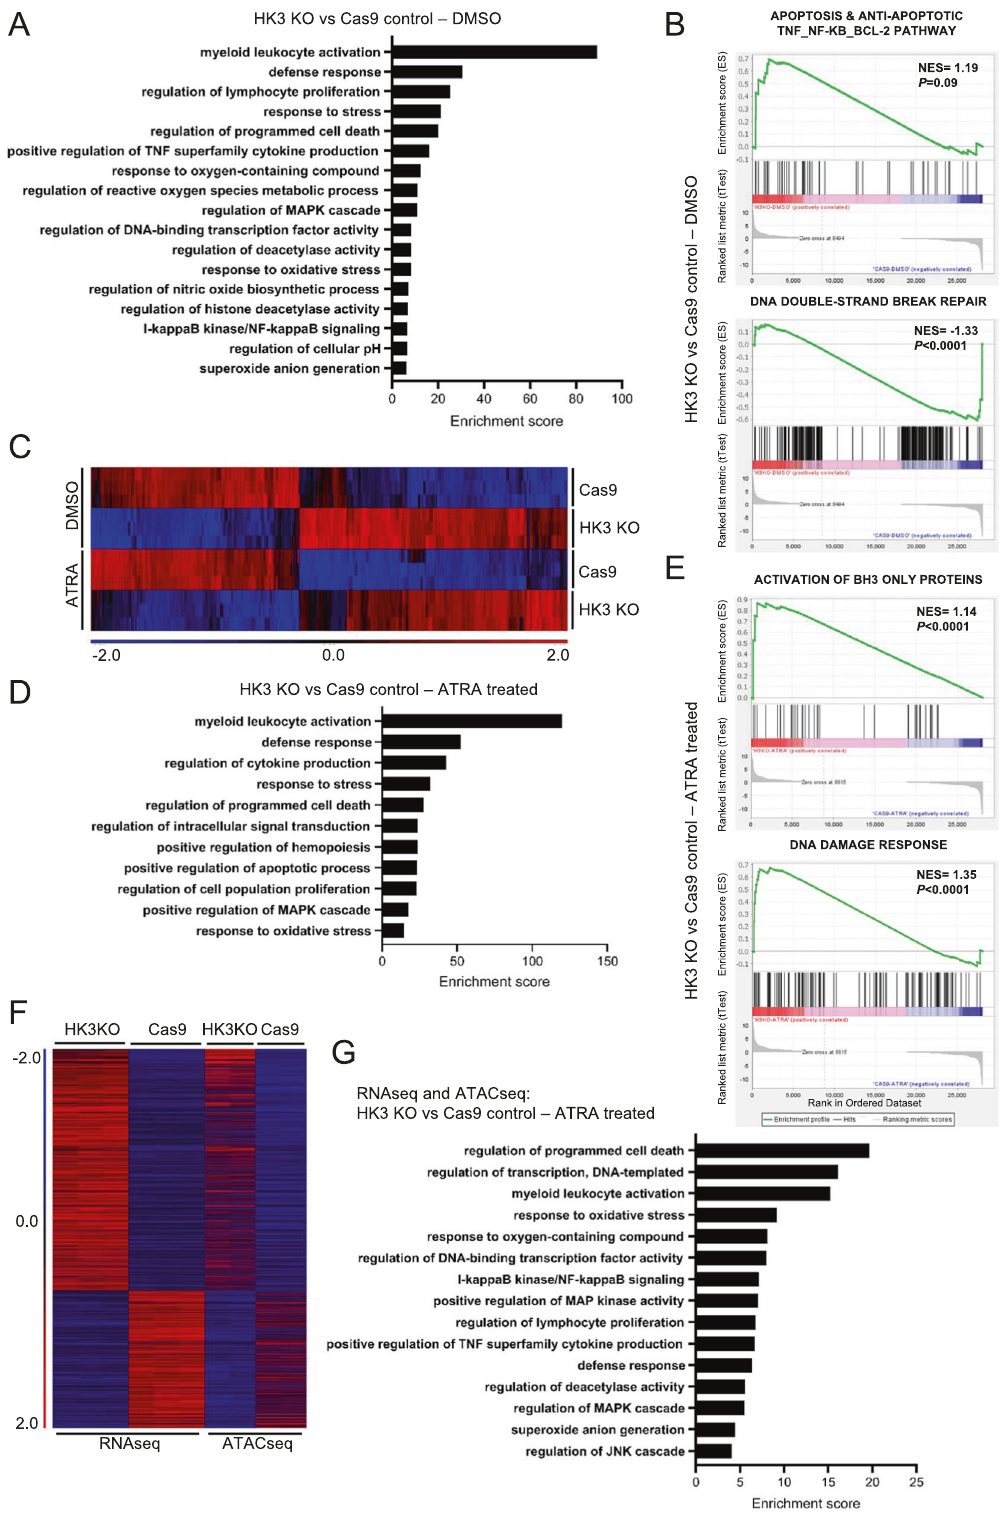
Fig. 5 RNAseq and ATACseq analysis reveal enrichment and increased accessibility of cell death and stress pathways in HK3 -null AML cells. A Gene ontology (GO) analysis of upregulated genes ( HK3 -null vs Cas9 control). B Gene set enrichment analysis (GSEA) represents the normalized enrichment score (NES) of indicated gene sets. C Heatmap of differentially expressed genes in DMSO and ATRA-treated HK3 -null and control samples. D Gene ontology (GO) analysis of upregulated genes in ATRA-treated samples ( HK3 -null vs Cas9 control). E Gene set enrichment analysis (GSEA) represents the normalized enrichment score (NES) of indicated gene sets in HK3 -null vs Cas9 control after ATRA treatment. F Heatmap of differentially regulated genes across RNAseq and ATACseq datasets among ATRA-treated samples of HK3 -null and Cas9 control cells. G Gene ontology (GO) analysis of genes upregulated in both RNAseq and ATACseq analysis under ATRA treatment ( HK3 -null vs Cas9 control). Cell Death and Disease (2022)